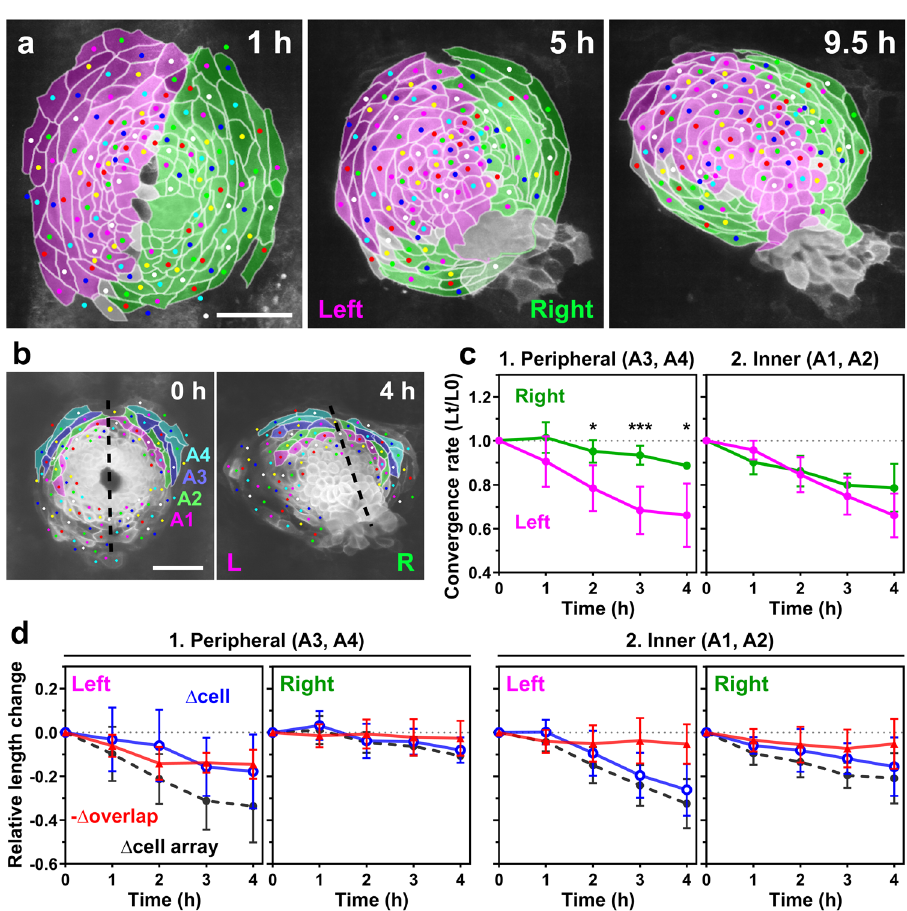
Fig. 5 The left and right heart primordia undergo asymmetric convergence during heart tube rotation. a Cells derived from the left (magenta) and right (green) primordia are color-coded. The posterior border of the left and right primordia shifted from 6 o ’ clock to 7 – 9 o ’ clock, suggesting that the left primordium converged more rapidly than the right one. Cells with ambiguous left-right origins are left uncolored. The original corresponding images are shown in Fig. 4a. Scale bar = 50 µ m. b – d Quanti fi cation of the convergence of the left (L) and right (R) primordia. We analyzed the anterior portion of the primordia (colored regions in b ) because the posterior portion of the right primordium became hidden due to their involution shortly after heart rotation started. The dashed lines in b indicate the boundary of the left and right primordia. Scale bar = 50 µ m. c Plots of the relative lengths (Lt/L0) of peripheral (1) and inner (2) cell arrays in wild-type embryos. Lt is the length at time t, L0 is the length at t = 0. The left (magenta plots) peripheral cell arrays (A3 and A4 in b ) converged more rapidly than the right (green plots) ones, whereas no signi fi cant difference was observed between the left and right cell arrays in the inner region (A1 and A2 in b ). * p < 0.05, ** p < 0.01, *** p < 0.005 (two-tailed t -test assuming unequal variances, n = 3 embryos). Means ± s.d. are shown. d Relative length changes of cell arrays (black), cells (blue), and loss of the cell lengths caused by the cell overlap (red) in the peripheral (1) and inner (2) cell arrays in wild-type embryos. n = 3 embryos. Means ± s.d. are shown. For c , d , corresponding graphs indicating individual data points are shown in Supplementary Fig.